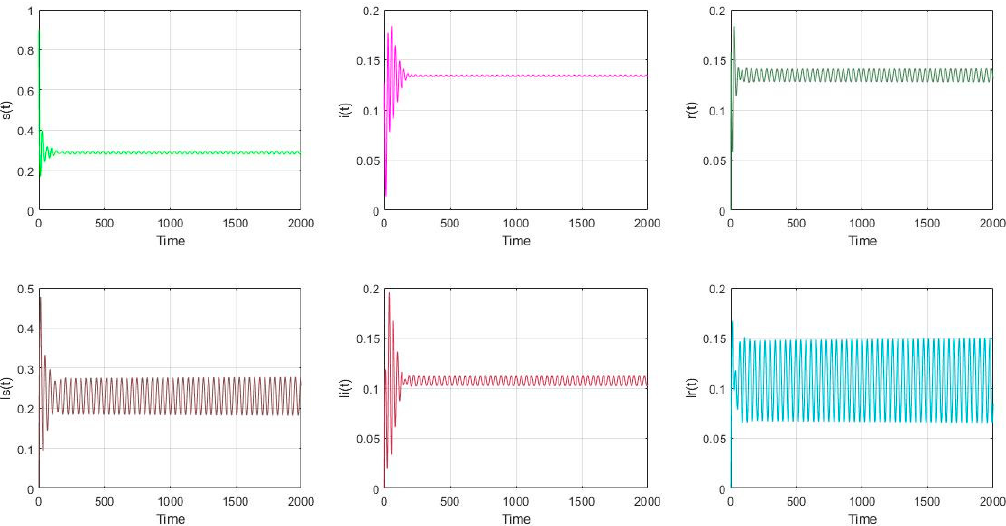
Figure 7. The distribution of nodes if R 0 = 1.4029 and τ = 11.74 > τ 0 = 11.5370.